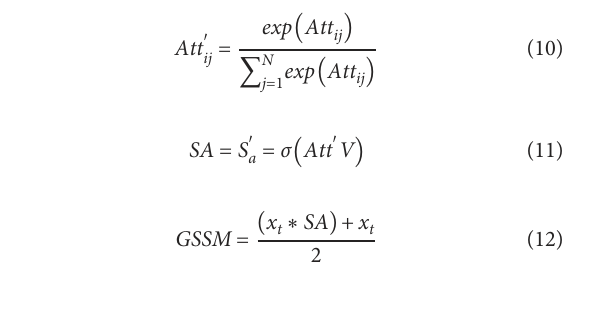
FIGURE 2 Self-attention module.